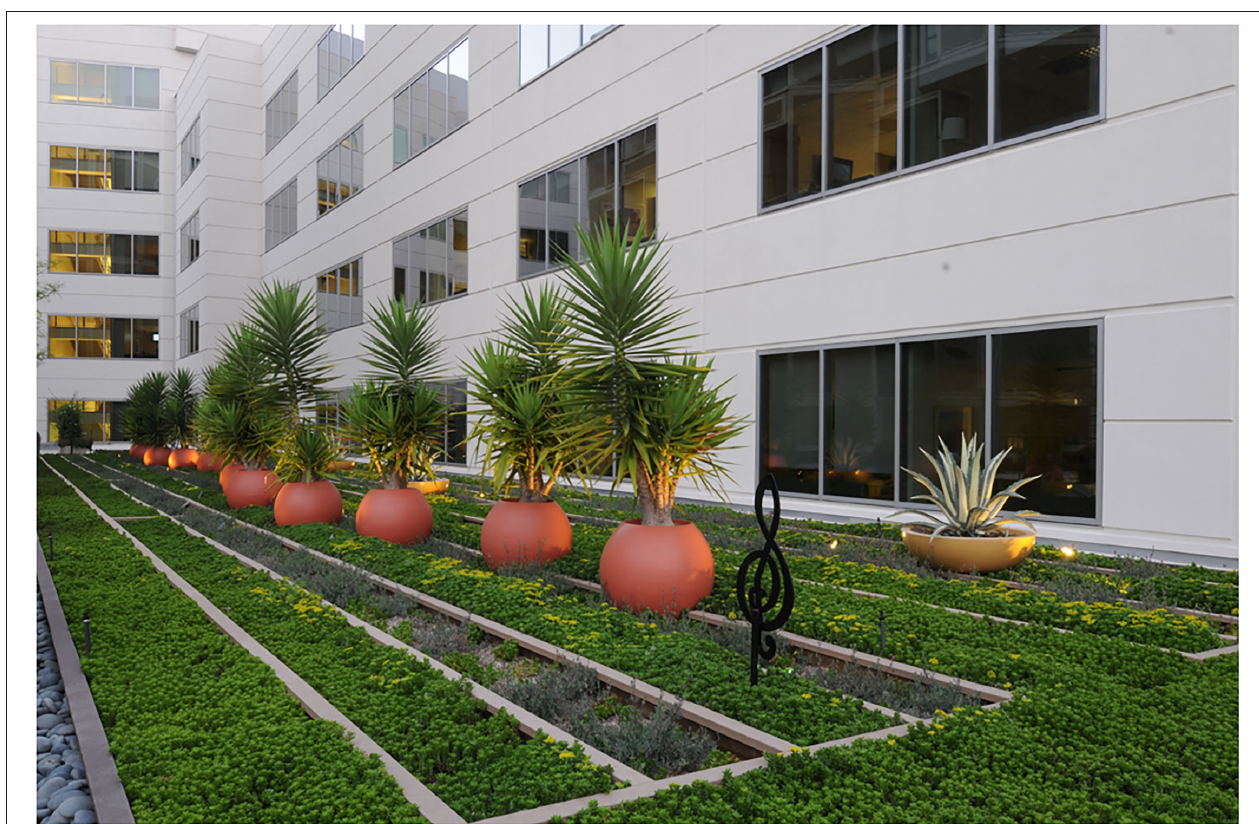
FIGURE 5 | A patient’s view of native Southern California plants used in the design of the extensive green roof garden located on Sharp Memorial Hospital’s emergency room (photograph used with permission, Schmidt Design Group,